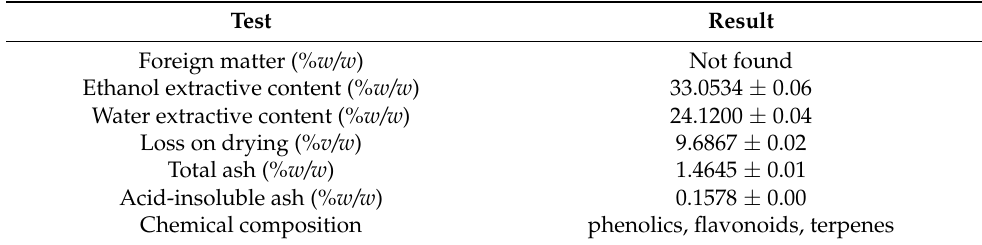
Table 1. Physical and chemical properties of root of L. martabanica .